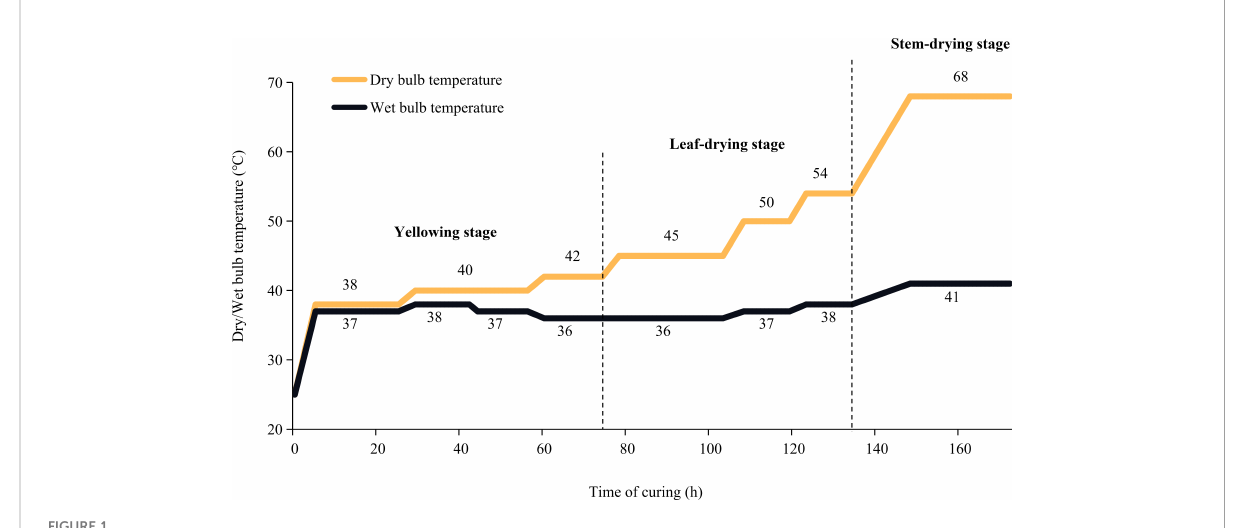
FIGURE 1 Flue-curing